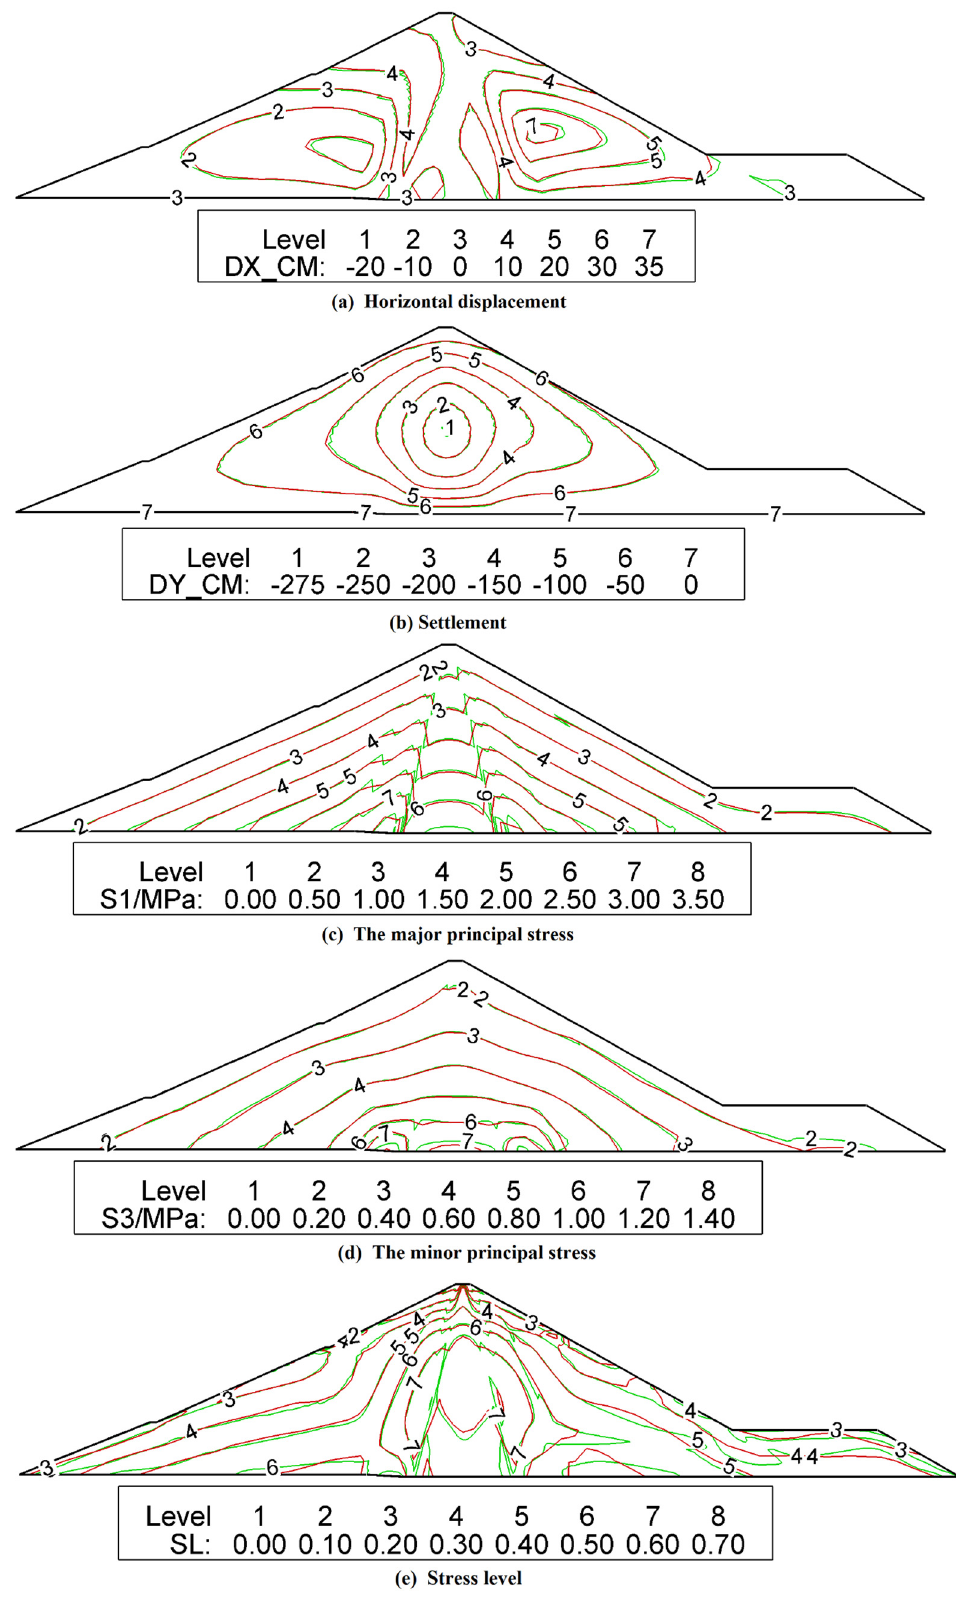
Figure 10. The calculated results of the 240.0 m section during the completed construction period.